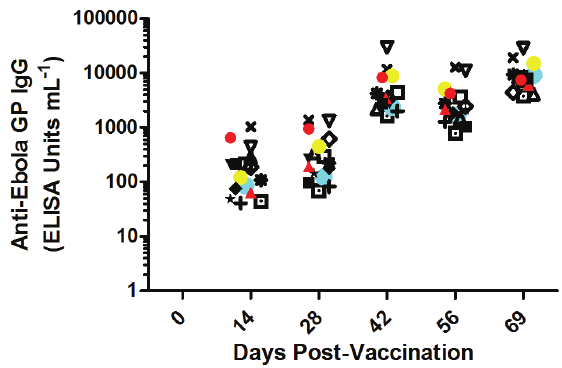
Figure 2. Immunogenicity of EBOV GP-based vaccination prior to challenge. Sixteen monkeys were vaccinated on Day 0 and boosted on Days 28 and 56. Each animal’s anti-Ebola virus glycoprotein titers are shown as unique symbols at each time point. Animals were challenged with EBOV on Day 72 post-vaccination. Red symbols are animals that succumbed to 7U challenge stock ( n = 2). Blue symbols are animals that succumbed to 8U challenge stock ( n = 1). Yellow symbols represent the n = 1 animal euthanized for humane reasons un-attributable to Ebola virus exposure. None of the data points were significantly different from each other at each time point.